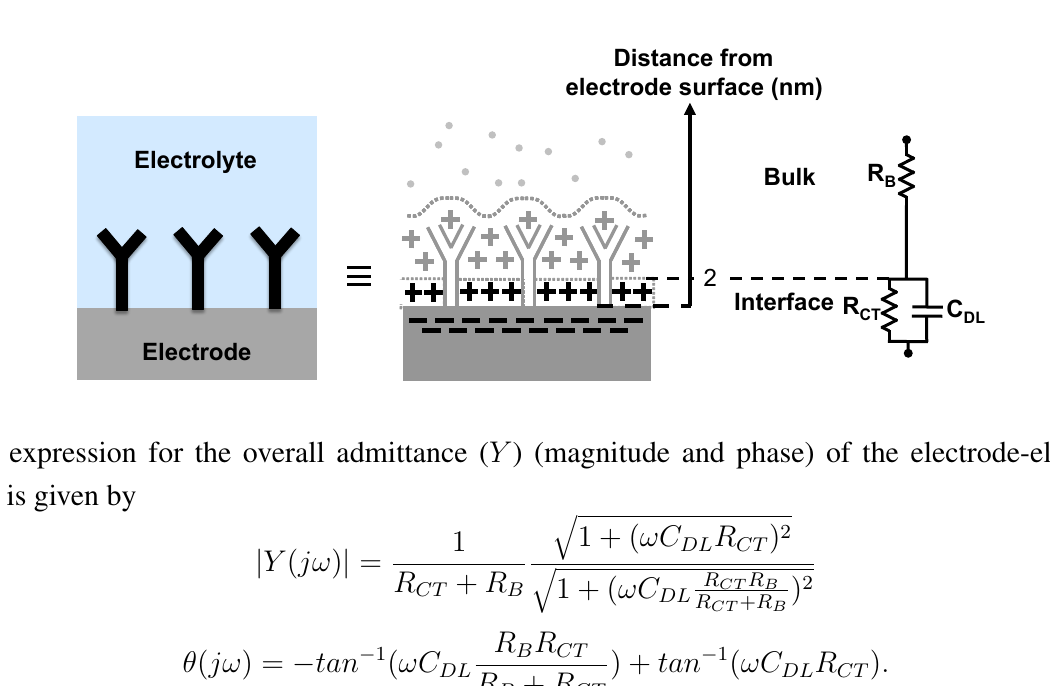
Figure 2. Circuit model of an electrode-electrolyte